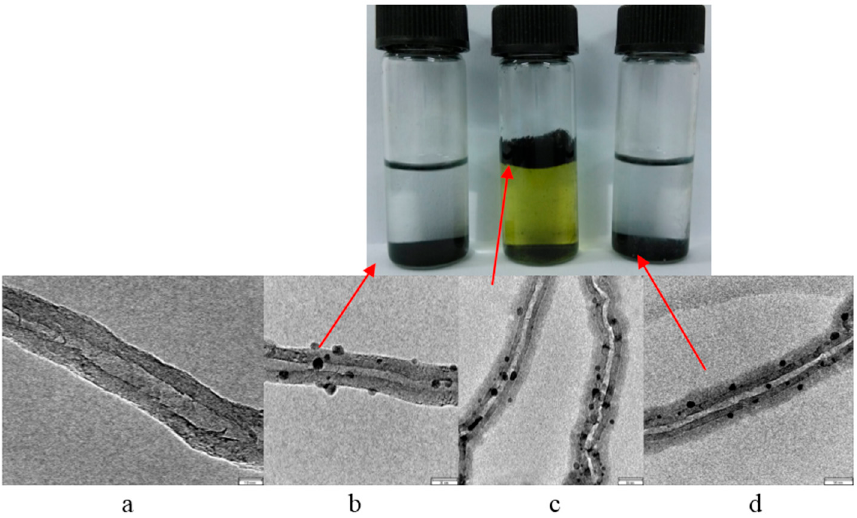
Figure 1. Transmission electron microscope images. MWCNTs: ( a ) purified; ( b ) magnetic; ( c ) MPTS-coated (MPTS M-MWCNTs); ( d ) hematin functionalized (hematin-MPTS-M-MWCNT). Scale bars: a—10 nm; b—20 nm; c—30 nm; d—30 nm. The arrows indicate the corresponding MWCNTs in the solutions (photographs in the upper section).